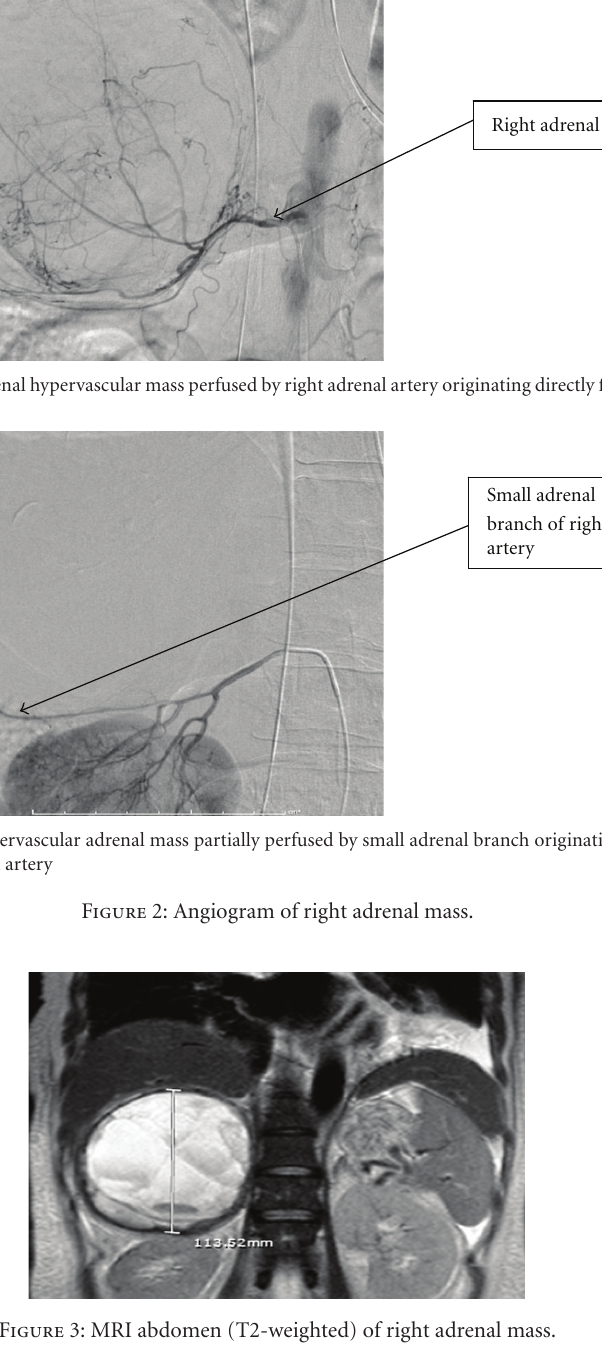
Figure 3: MRI abdomen (T2-weighted) of right adrenal